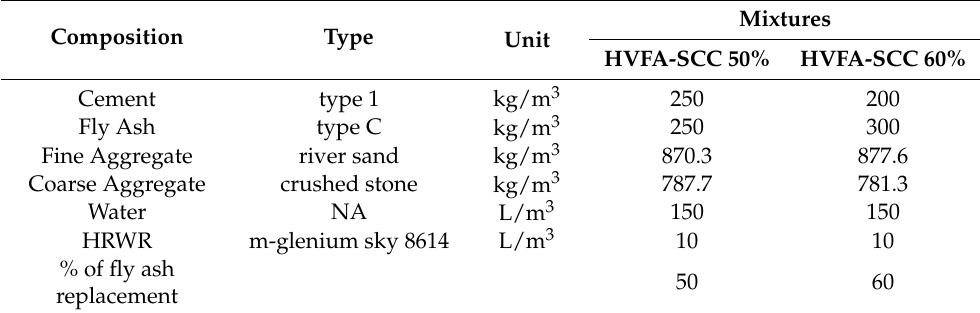
Table 2. Material proportions in HVFA-SCC beams.